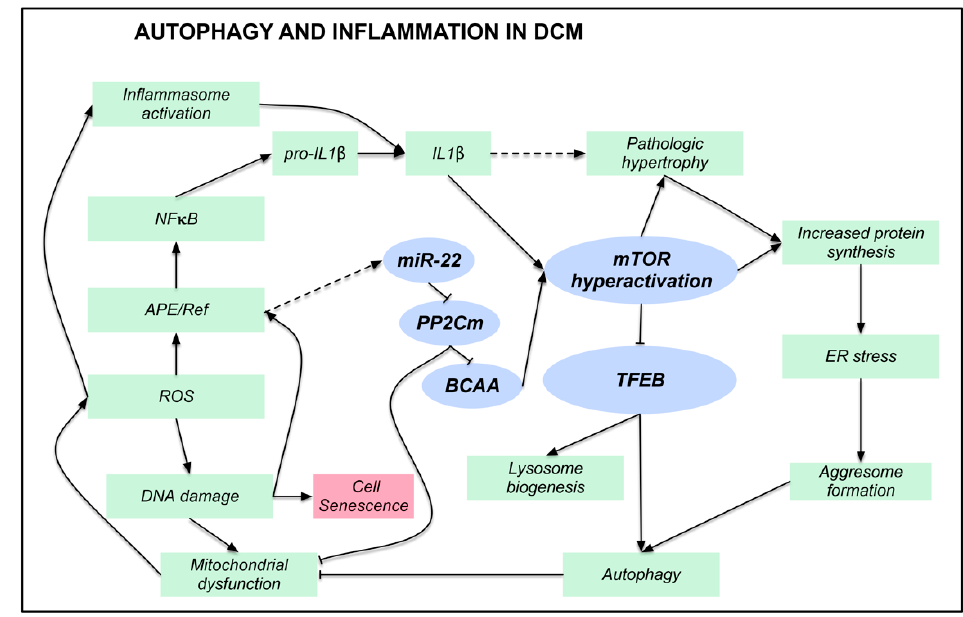
Figure 7. Autophagy and inflammation in DCM. Illustration summarizing the main findings described in human DCM samples. Blue ellipses indicate the key actors of this process. Dashed arrows indicate correlative or literature findings. Arrows with blunt ends indicate inhibition, while pointed arrows indicate activation.